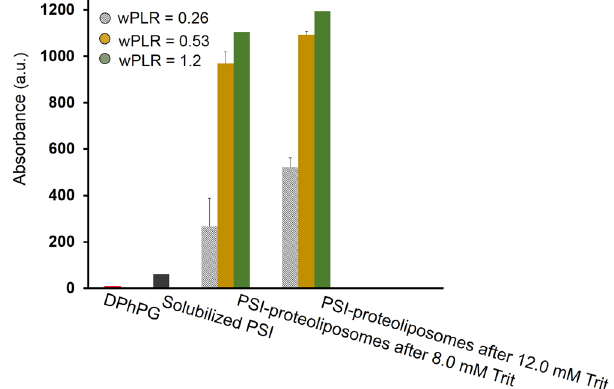
Figure 5. Comparisons of the maximum absorbance intensities at 680 nm as obtained from the SEC elution profiles in Fig. 4.